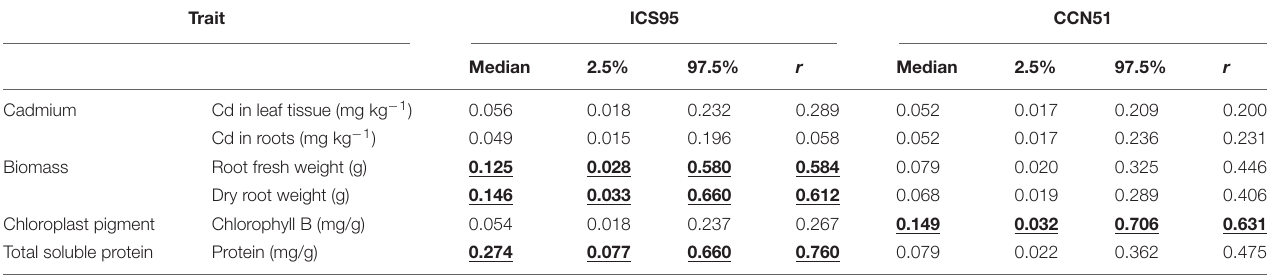
TABLE 3 | Narrow-sense rootstock-mediated heritability ( h 2 ) in cacao seedling rootstocks from controlled crosses 2 months after grafting with the ICS95 and CCN51 scions.